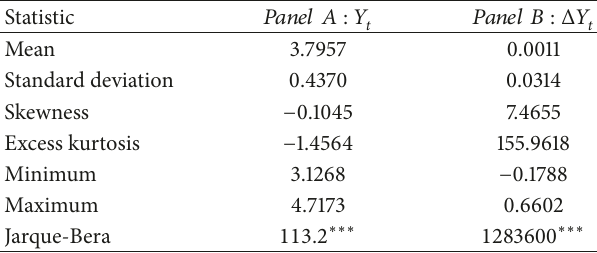
Table 2: Summary